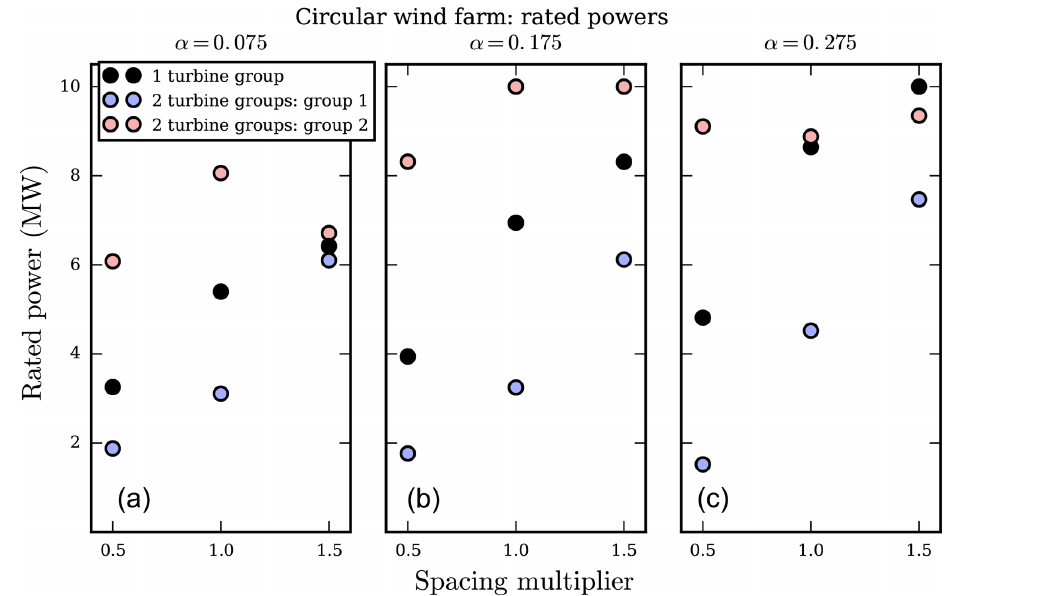
Figure 12. The optimal rated powers for the circular wind farm for the optimization runs with coupled layout and turbine design for both uniform wind farm turbine design and with two different turbine design groups. The three subfigures show a different shear exponent, with α = 0 . 075, 0 . 175, and 0 . 275 from (a) to (c) . Within each subfigure, the x axis shows different farm spacing multipliers, with β = 0 . 5, 1 . 0, and 1 .